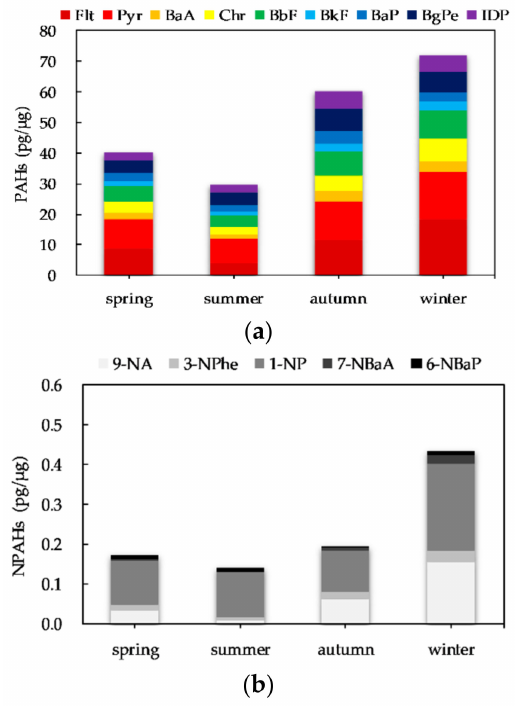
Figure 3. Seasonal variation in composition of PAHs and NPAHs in PM 2.5 : ( a ) PAHs; ( b )NPAHs.